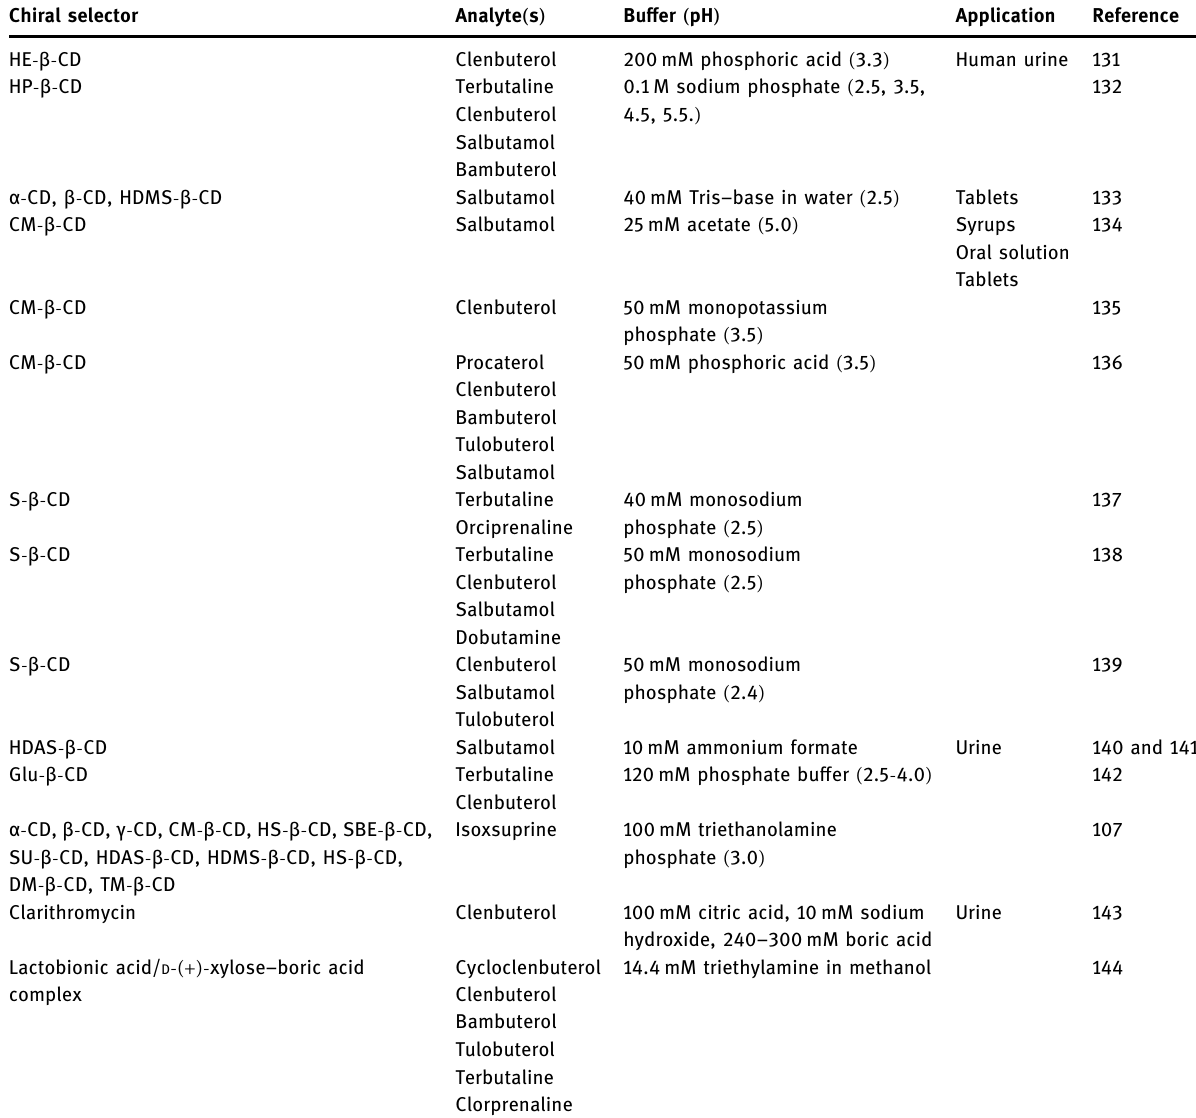
Table 3: Enantiomeric separation of β - agonists by CE methods Chiral